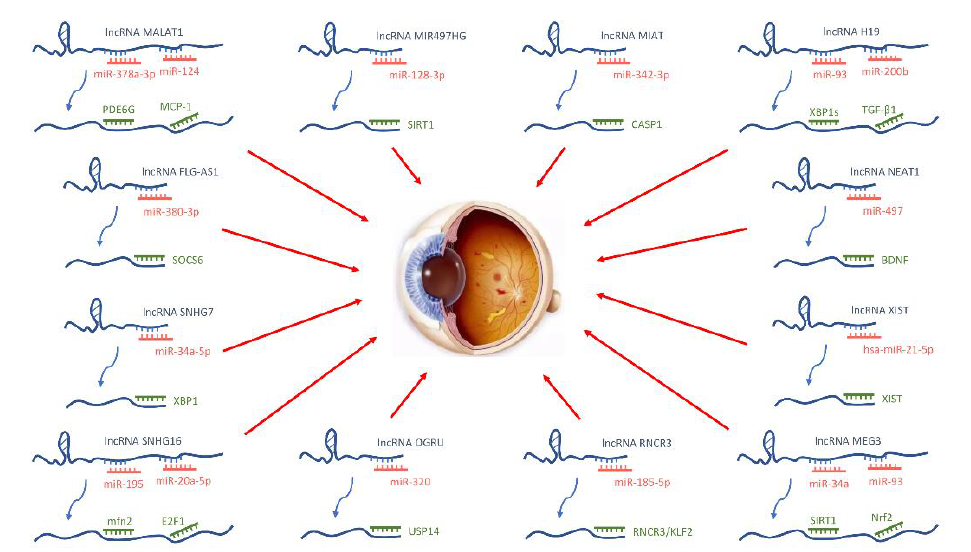
Figure 4. Schematic overview of lncRNAs promoting the pathogenesis of DR. IncRNAs regulate miRNAs in the progression of DR as well as the expression of related genes during transcription or epigenetic mechanisms to affect the progression of DR.